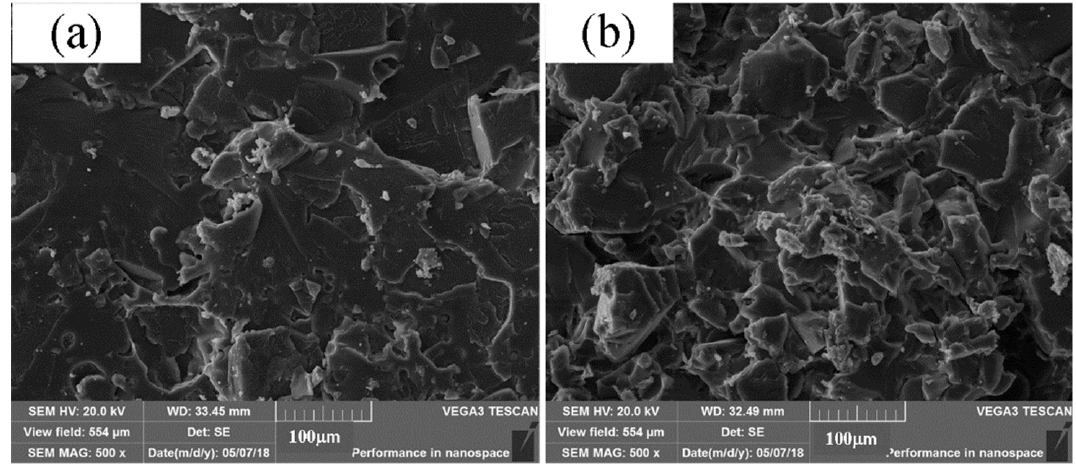
Figure 12. Microstructure of fracture surface. ( a ) Curing agent T31; ( b ) curing agent 593.